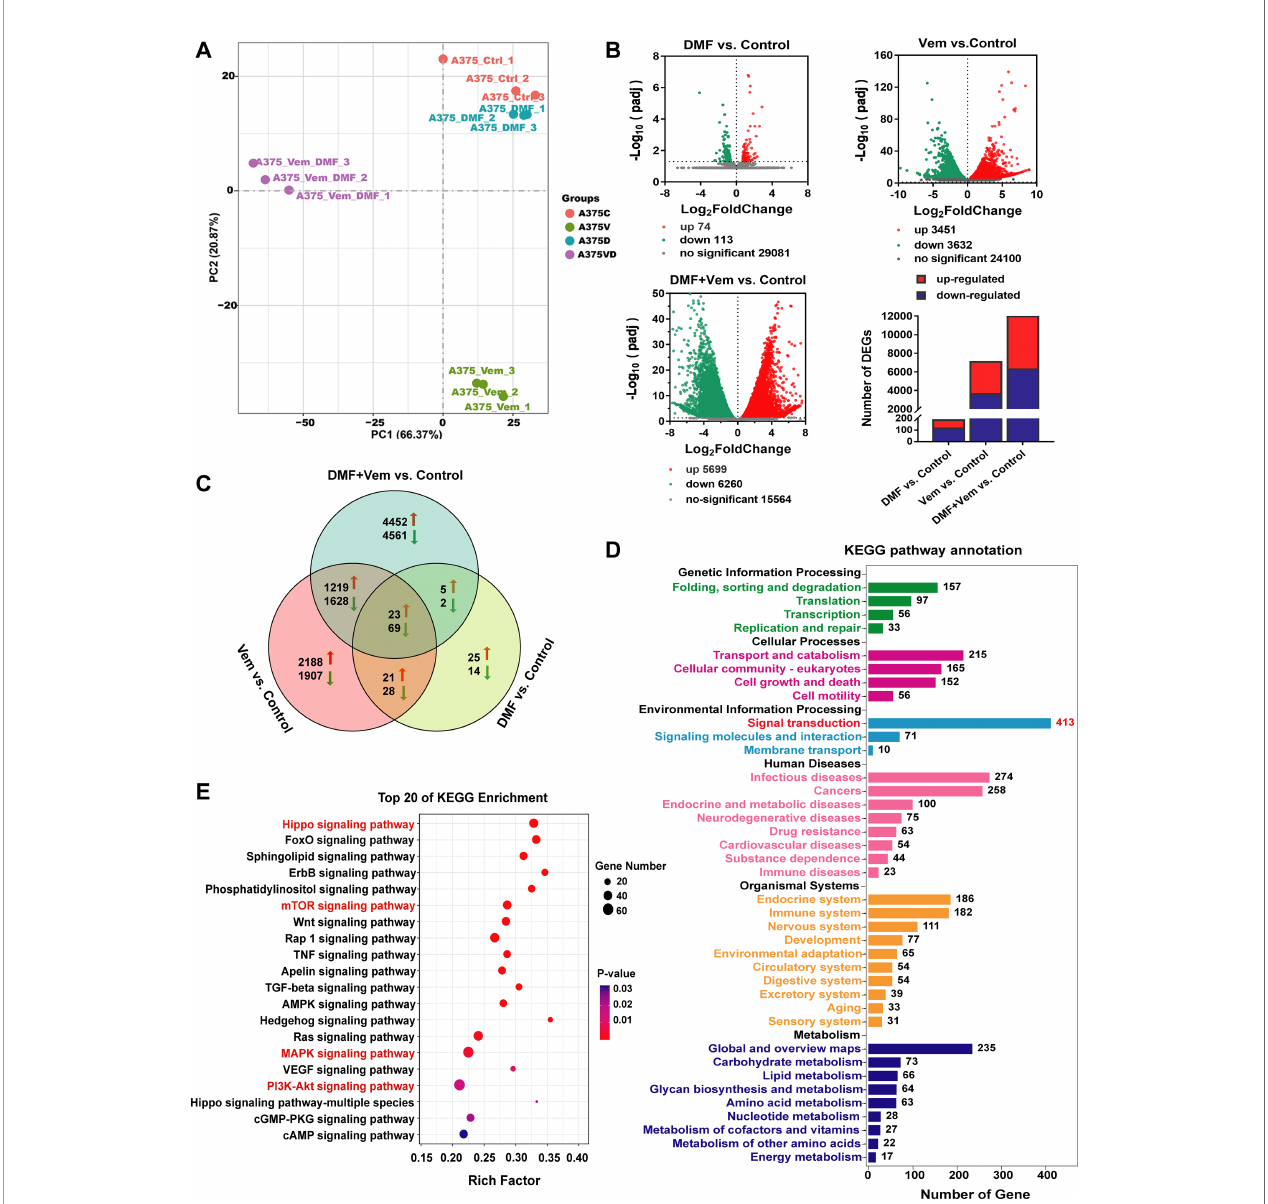
FIGURE 4 | Transcriptomic analysis of A375 cells following DMF/Vem treatment. (A) PCA plots were used to represent A375 cell transcripts detected via RNA-seq following treatments with 50 m M of DMF and/or 2 m M of Vem for 24 h. (B) Volcano plots were used to analyze transcriptomic data, with the x-axis representing Log 2 FoldChange (sample/control) values and the y-axis representing the -Log 10 (padj). Green, red, and gray circles respectively represent genes that were downregulated, upregulated, and not differentially regulated. (C) Venn diagrams demonstrating the numbers of up- and down-regulated transcripts associated with each treatment. (D) KEGG pathway enrichment analysis of DEGs that were speci fi cally downregulated in the context of DMF/Vem treatment. (E) The top 20 enriched KEGG signal transduction pathways, P <